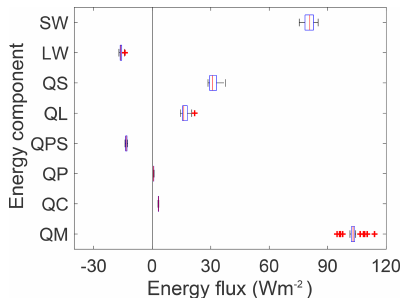
Figure 8. The energy balance components averaged over all stakes has less uncertainty than on the point scale for HEF 2012. The ob- jective functions are all integrated over the whole glacier and thus the uncertainty is lower. Glacier wide the short-wave radiation is the largest component with the largest absolute uncertainty as well, followed by the turbulent fluxes. The long-wave balance and the penetrating short-wave radiation provide a net cooling effect for the